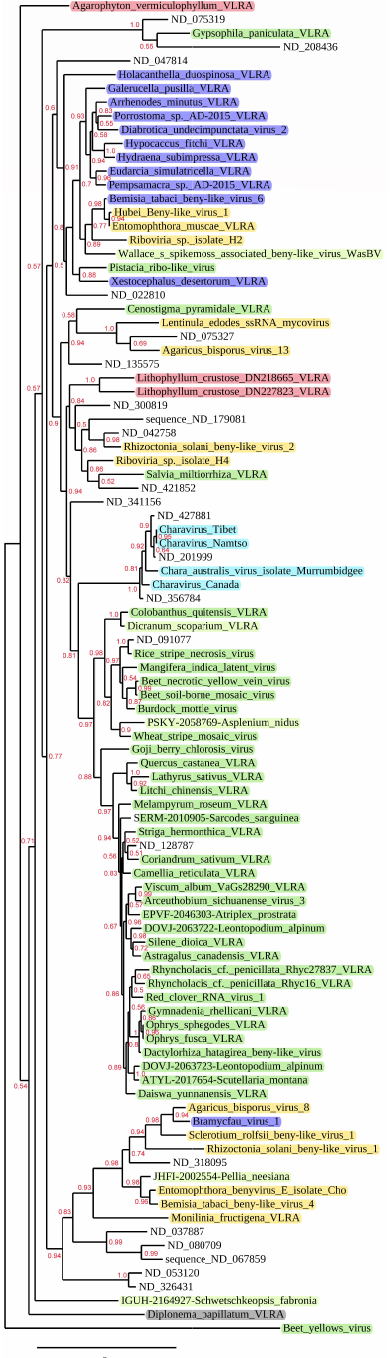
Figure 2. Phylogenetic analysis of the RdRp domains derived from the aligned deduced amino acid sequences of some benyviruses, benyvirus-like VLRAs and the selected beny-like viruses. The rooted phylogenetic tree (with the closterovirus species Beet yellows virus as the outgroup) was constructed using the maximum likelihood method based on amino acid sequence alignments. The bootstrap values obtained with 1000 replicates are indicated on the branches, and branch lengths correspond to the branch lines’ genetic distances. The genetic distance is shown by the scale bar at the lower left. Host specificity of the selected viruses is indicated by colors: green—flowering plants; light green—non-flowering plants; light blue—charophyte algae; pink—red algae; blue—arthropods; yellow—fungi; shading—euglenozoan